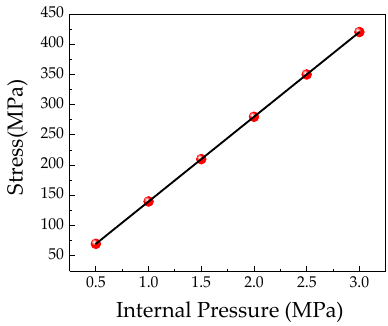
Figure 5. Relationship between the stress at crack tip and the internal pressure.